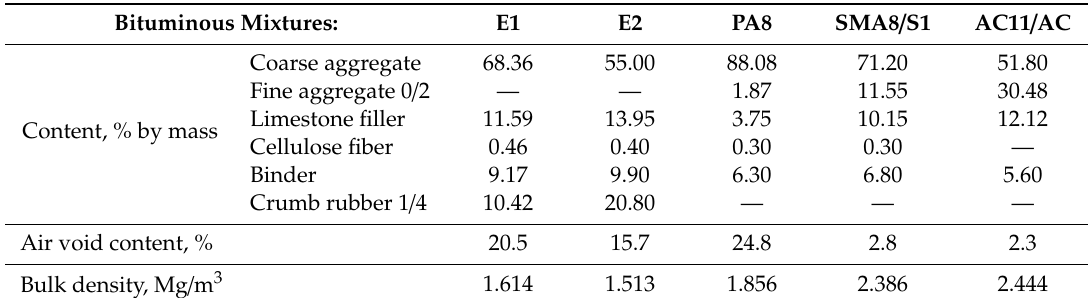
Table 1. Characteristics of the bituminous